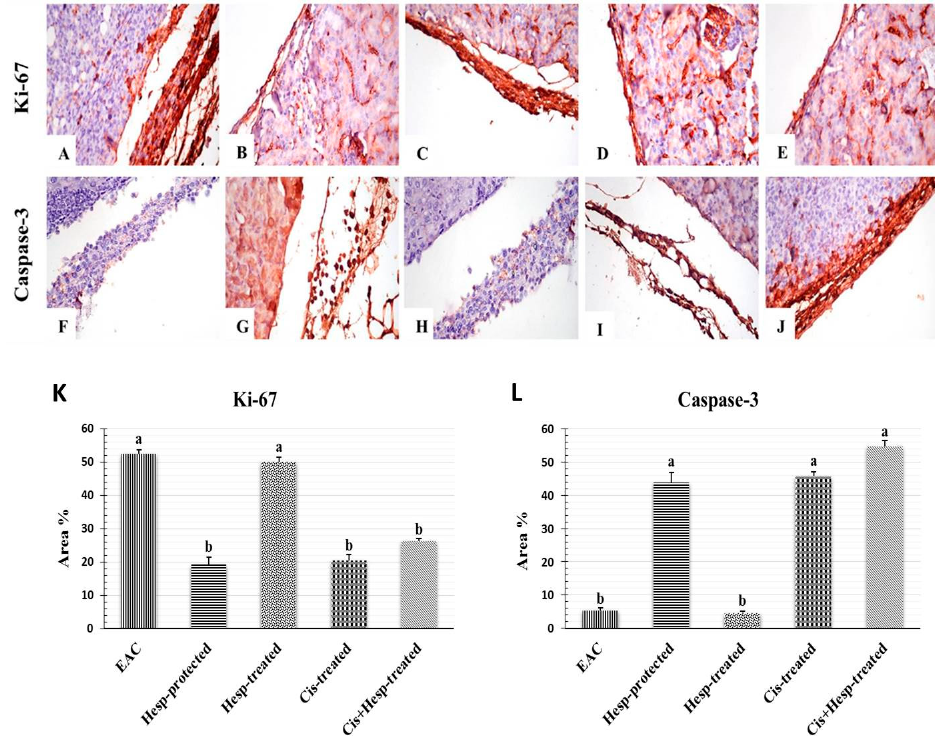
Figure 4. Photomicrographs of immuno-histochemical reactivity of Ki-67 ( A – E ) and caspase-3 ( F – J ) in renal capsule of different groups (×400). ( A , F ) EAC group showing strong expression of Ki-67 and no immune-reactive cells, with caspase-3 in neoplastic cells infiltrating renal capsule. ( B , G ) Hesp-protected group showing weak expression of Ki-67 and strong expression of caspase-3 in few neoplastic cells infiltrating renal capsule. ( C , H ) Hesp-treated group showing strong positive expression of Ki-67 and no immune-reactive cells with caspase-3 in neoplastic cells in renal capsule. ( D , I ) Cis-treated group showing weak expression of Ki-67 and strong expression of caspase-3 in neoplastic cells infiltrating renal capsule. ( E , J ) Cis+Hesp-treated group showing weak expression of Ki-67 and strong expression of caspase-3 in renal capsule. ( K , L ) Immunostaining expression of Ki-67 and caspase-3 area % in neoplastic cells of different treated groups; the values are expressed as means ± SE ( n = 5). Different letters (a, b) indicate significant differences at p < 0.05. EAC: Ehrlich ascites carcinoma; Hesp: hesperidin; Cis: cisplatin.